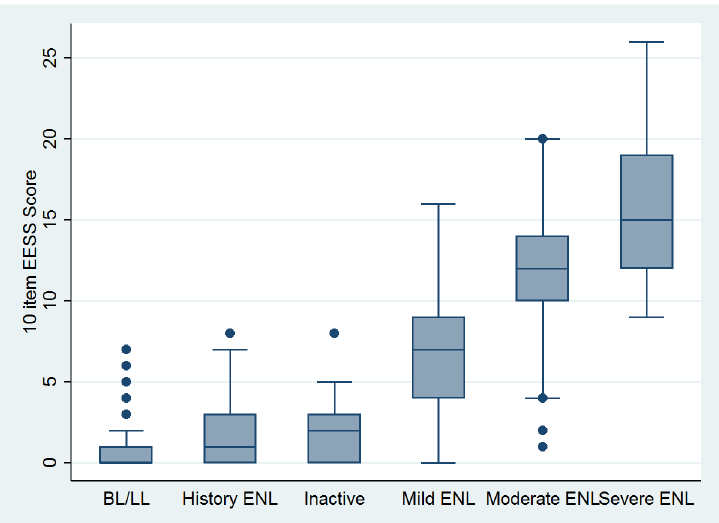
Fig 1. Box plot of the 10 item scale by expert classification showing medians, interquartile ranges and minimum and maximum scores.